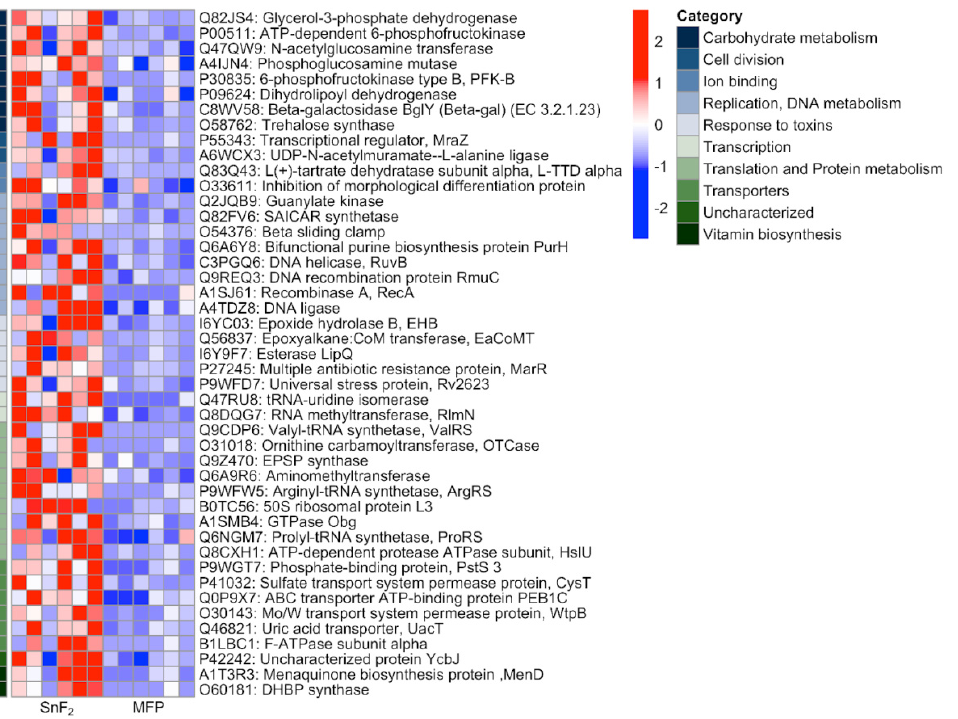
Figure 11. Heat map showing gene expression values of top genes correlated with SnF 2 . Range of colors (red, pink, light blue, dark blue) shows the range of expression values (high, moderate, low, lowest).